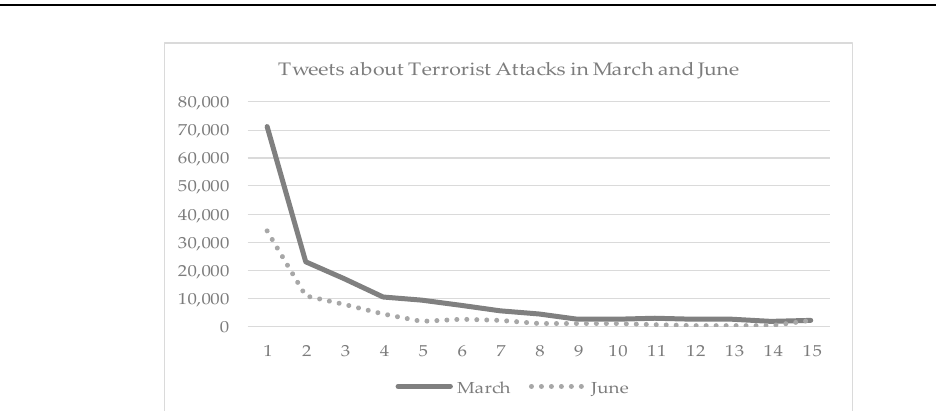
Table 2. Number of geotagged tweets in the UK.